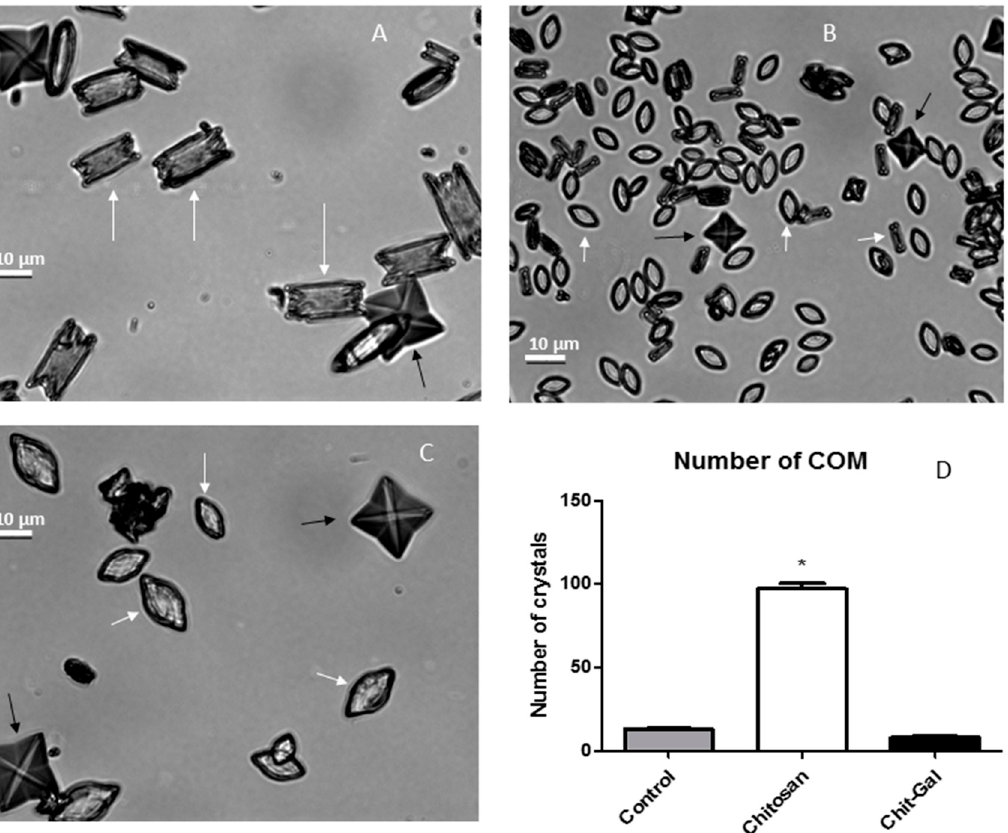
Figure 4. Morphology of crystals formed in the presence and absence of chitosan (Chit). ( A ) Absence of Chit (Control), ( B ) Chit, and ( C ) Chit-Gal. ( D ) Number of monohydrate crystals (COM) formed by field. White arrows, COM; black Arrows, dihydrate crystals (COD). Scale bar: 10 µ m. Different symbols indicate significant difference ( p < 0.05).